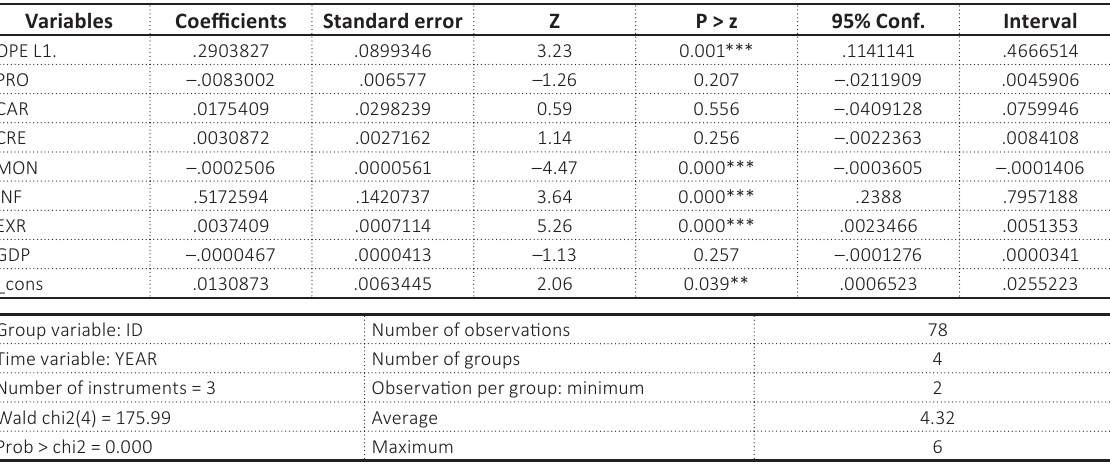
Table 5. Dynamic panel-data estimation, two-step